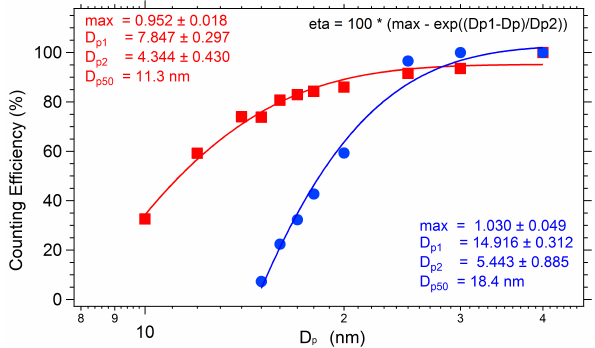
Figure 4. The counting efficiency of the CPCs with different detec- tion limits (11 and 18nm respectively) depending on the particle di- ameter ( D p ). The difference between the readings of the two CPCs provides the number concentration of ultrafine particles that are an indicator for new particle